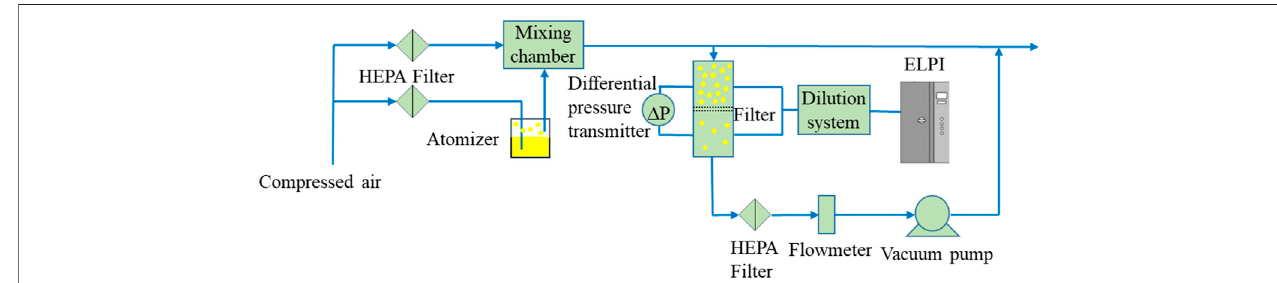
FIGURE 2 | Experimental